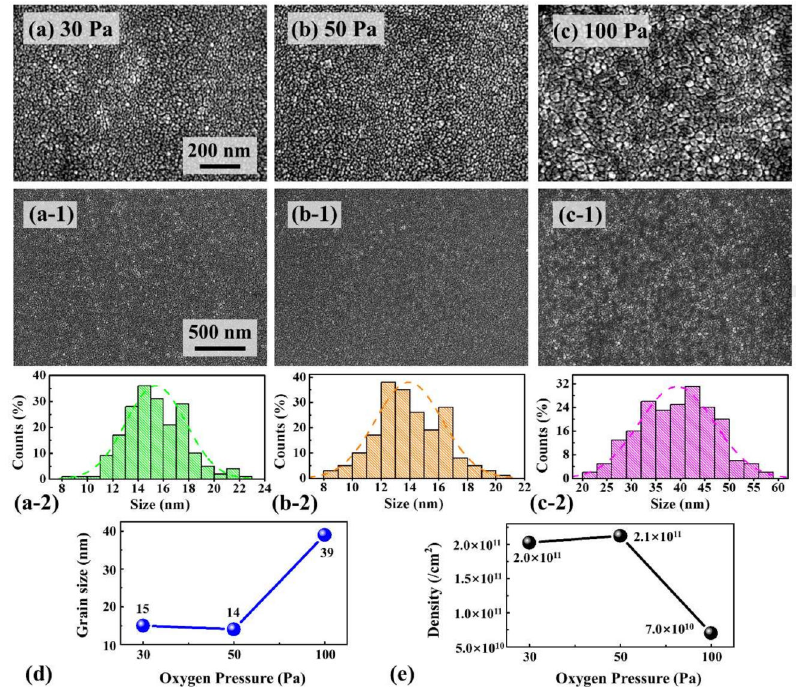
Figure 8. SEM images of PLZT thin films annealed at various oxygen pressure: ( a ) 30; ( b ) 50; and ( c ) 100 Pa. SEM images are: 1.2 ( x ) × 0.8 ( y ) µ m 2 ( a – c ); and 2.4 ( x ) × 1.6 ( y ) µ m 2 ( a-1 – c-1 ). ( a-2 – c-2 ) The distribution histogram and Gaussian fitting of the grain diameter of PLZT thin films; ( d ) the average grain size; and ( e ) the average density of each